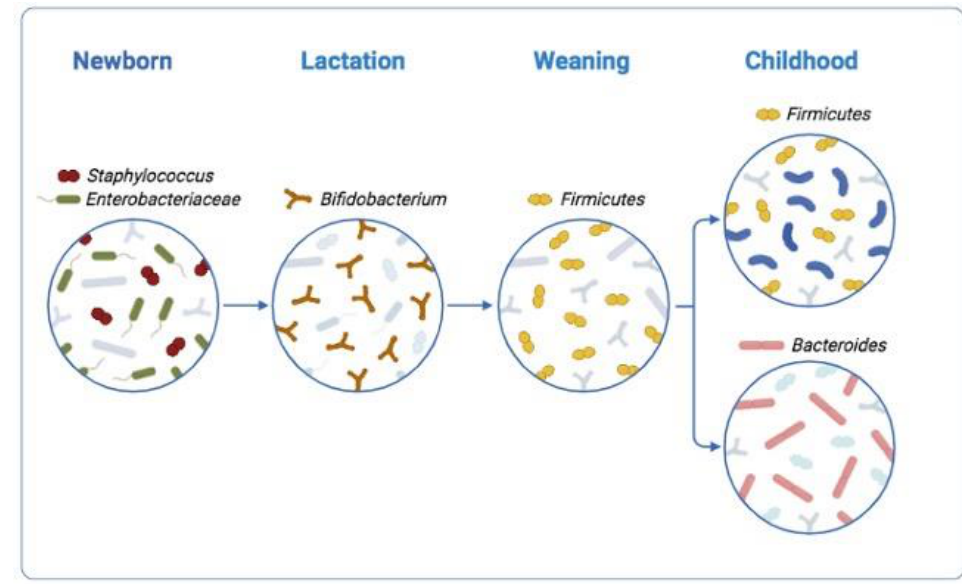
Figure 1. Gut microbiota development, from birth to